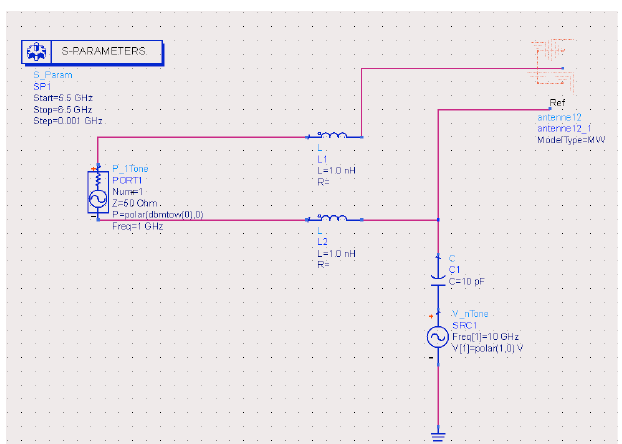
Figure 13: Equivalent circuit of patch antenna proposed